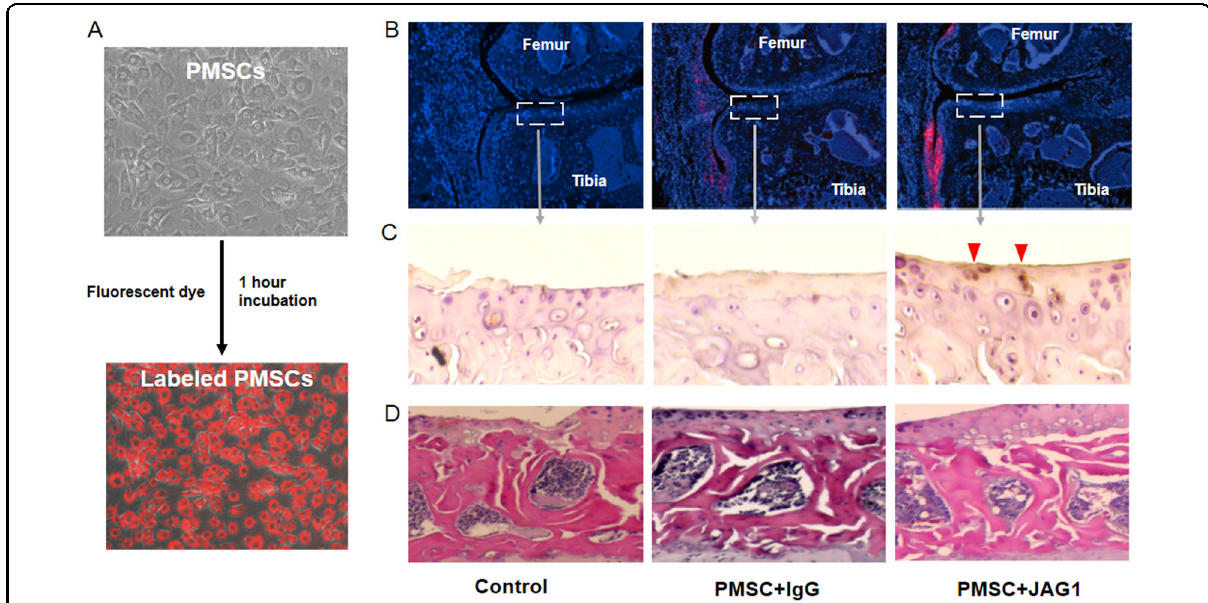
Fig. 5 Tracing of PMSCs in the mouse knee joint. a Qtracker ® reagent-labeled PMSCs showed strong red fl uorescence after 1 h of incubation in the culture. b Mouse knee joints injected with 0.2 million red fl uorescent-labeled JAG1-treated PMSCs showed more live PMSCs invading synovial tissue surrounding the arti fi cial cartilage than joints injected with untreated PMSCs at 4 weeks after cell injection. c Immunohistochemistry staining (IHC) of human PMSCs using the anti-human nuclear antigen antibody in tibia articular cartilage from 8-week MLI mice (human nuclear antigen positive cells: red arrowheads). d H&E staining of subchondral bone in the mouse knee joint from control, PMSC and JAG1/PMSC groups at 4 weeks after cell